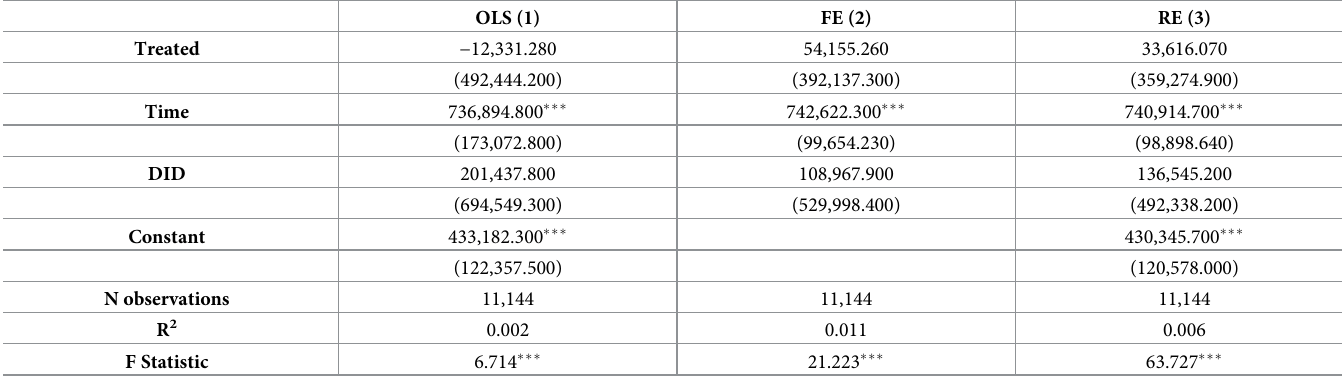
United States, the United Kingdom, and India [17–19]. Therefore, it can be concluded that encouraging organic production in the municipalities is a way to increase economic results. The difference-in-differences for GDP and agriculture GVA show that, for the production variables, there is no significant difference between 2017 and 2006 for the organic production hotspots (Tables 6 and 7). The only significant effect is when considering the growth of hotspot municipalities over time: R$ 742,622,000 for GDP and R$ 35,481,000 for agricultural GVA.